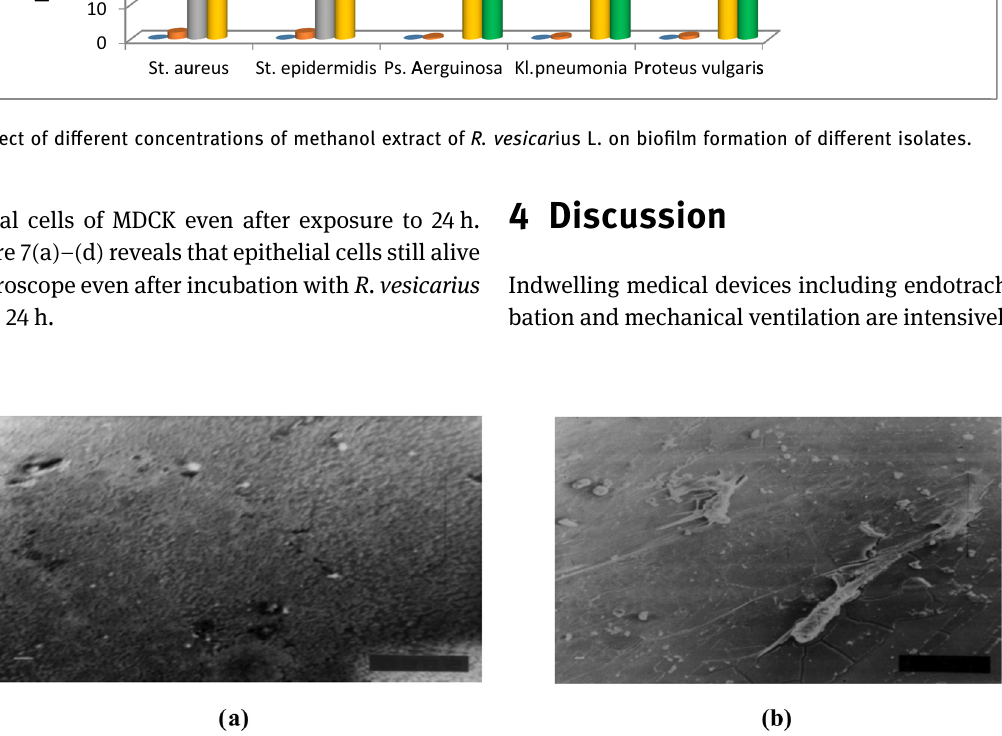
Figure 3: E ff ect of methanol extract of R. vesicarius L. on bio fi lm formation. ( a ) SEM image of St. epidermidis bio fi lms treated with DMSO and ( b ) treated with R. vesicarius 2,000 mg.